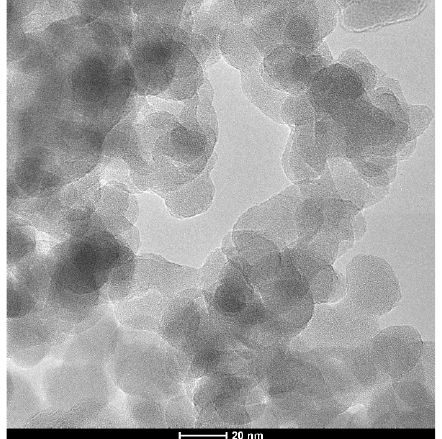
Figure 1. TEM images of the SiO 2 particles.